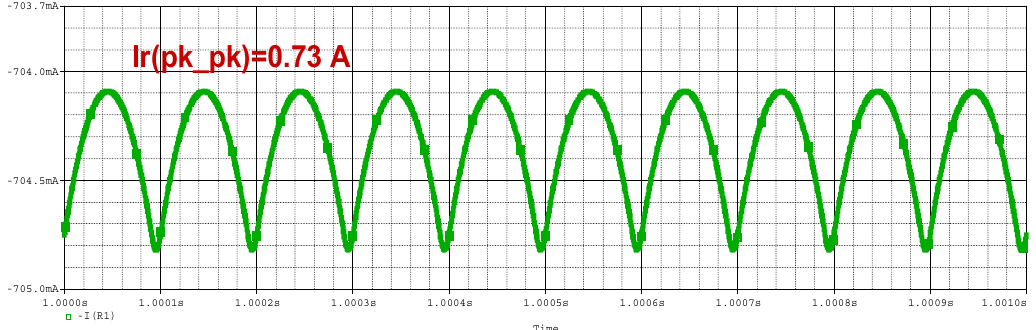
Figure 32. Output current ripples of the bidirectional C û k converter [33].